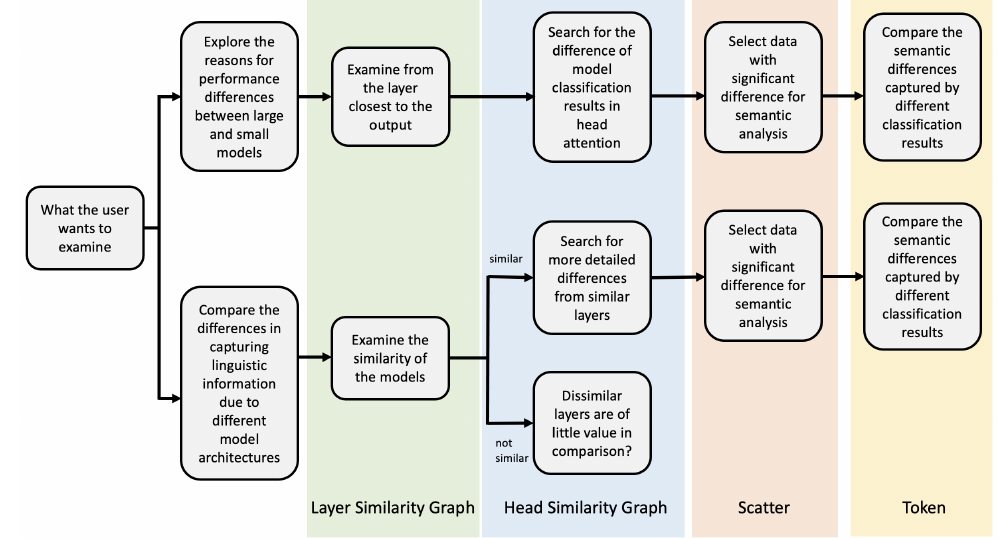
Figure 14. The common flow to use our visual analytics